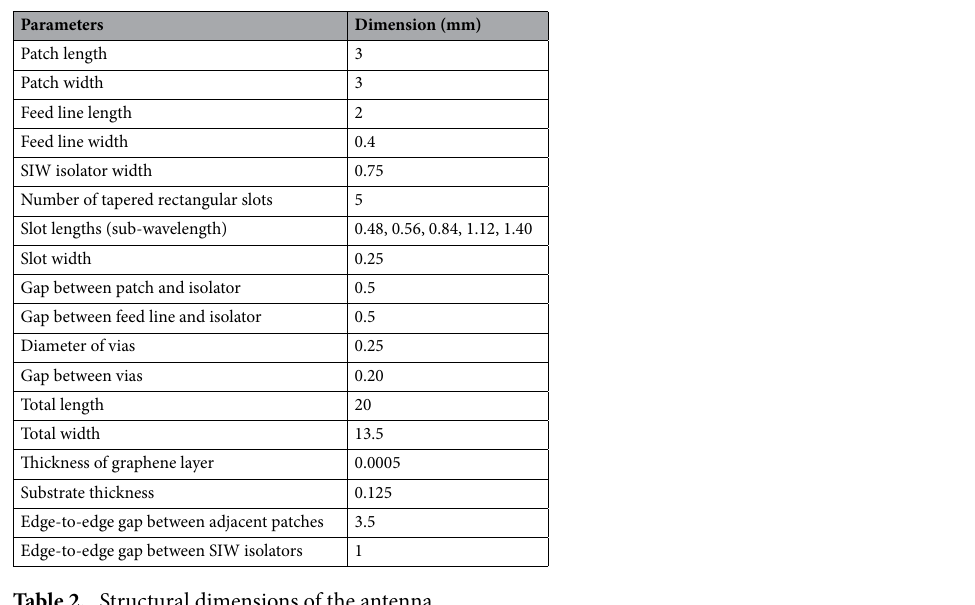
Figure 11. Simulated radiation gain and efficiency of the reference, SIW-loaded, and SIW-loaded MTM (CRLH) antennas.